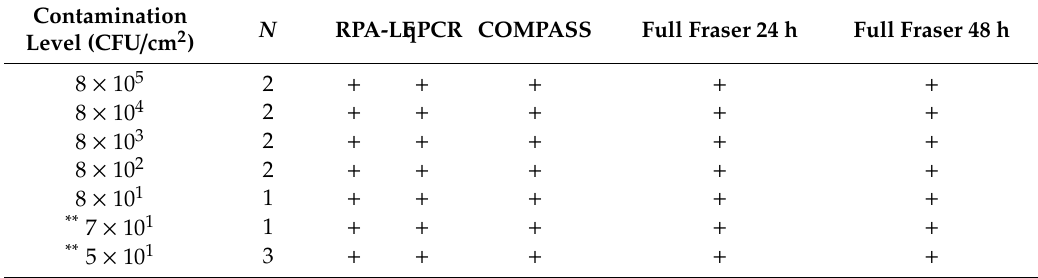
Table 3. Surface samples analysis by RPA-LF, qPCR and culture-based